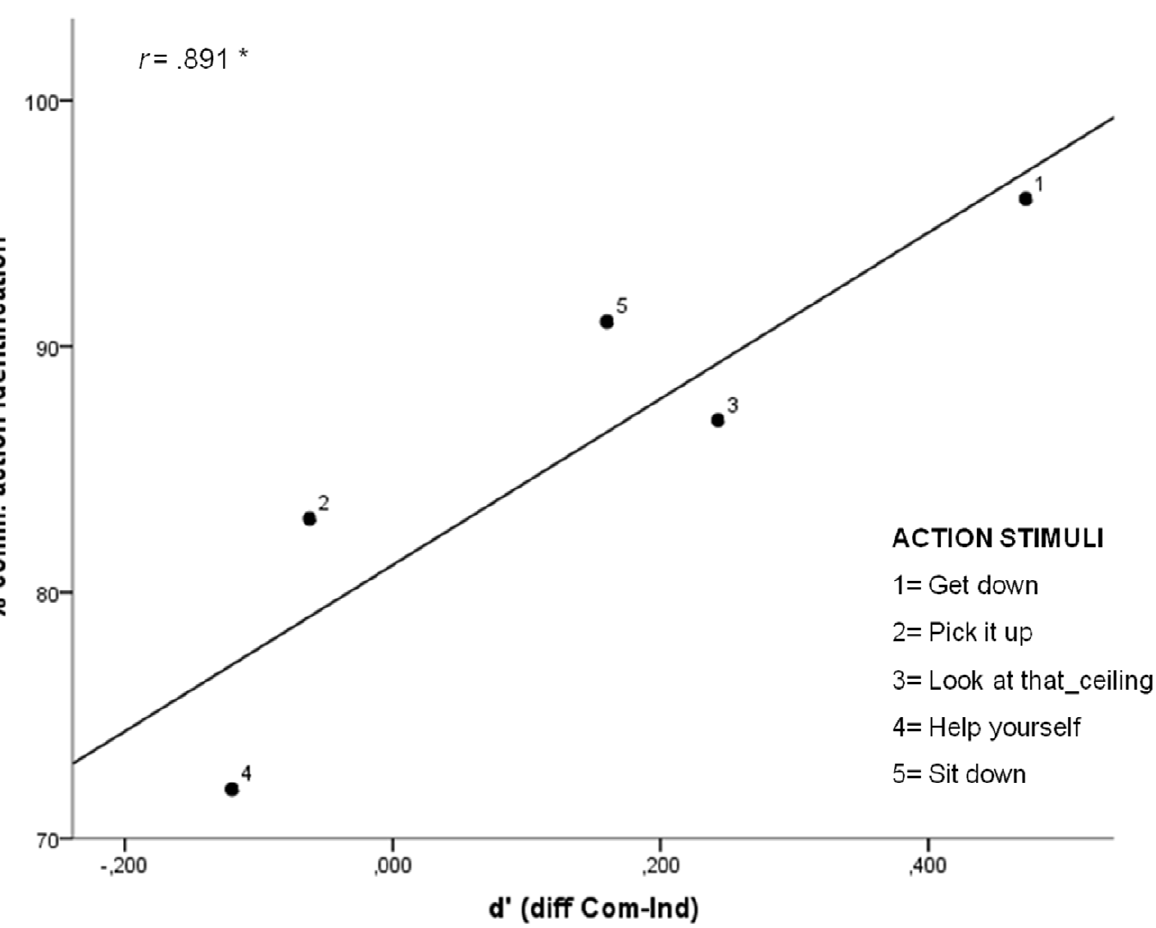
Figure 3. Scatter plot showing the correlation between communicative action identification and d’. Identificationscoresareplottedonthe ordinate, and represent the percentage of participants who correctly identified A’s communicative actions (normative data [12]). The difference between communicative condition and individual condition is plotted on the abscissa ( d’ ). The black line represents the linear regression line fitted to the data.